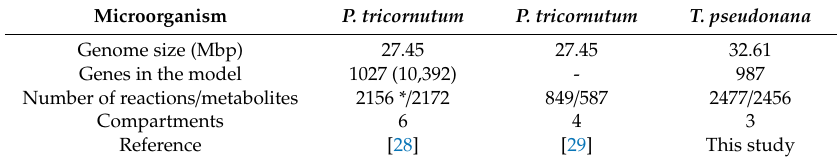
Table 2. Comparison of the i Thaps987 model with other published models of